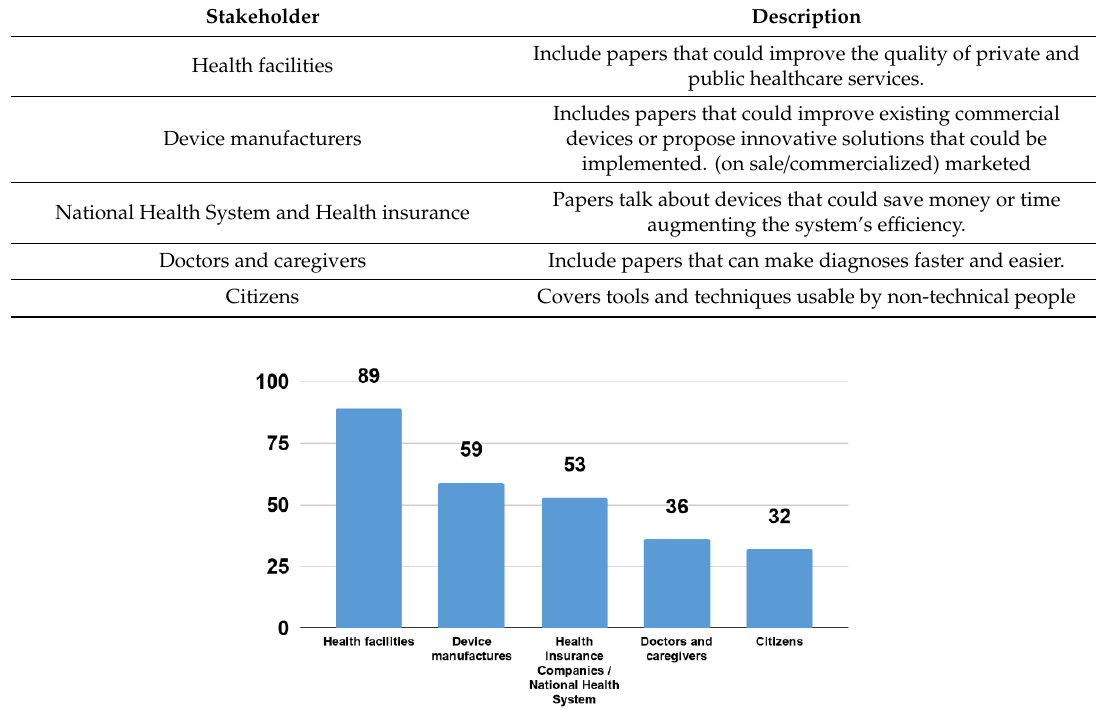
Table 3. Identified stakeholders’ definitions.